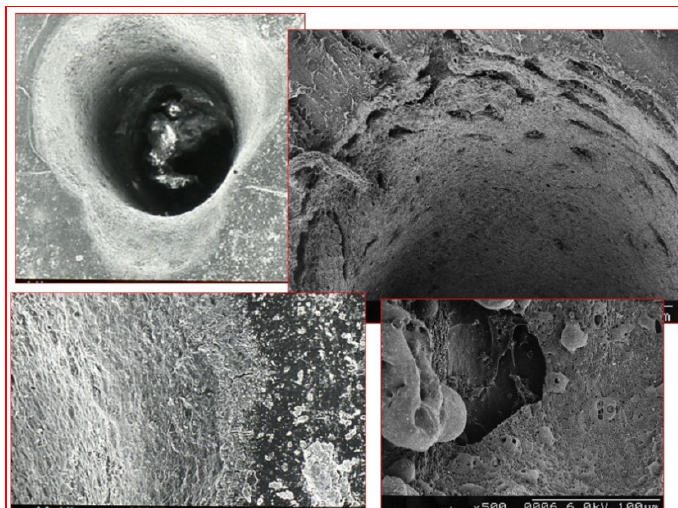
Figure 8. Scanning Electron Microscope (SEM) micrographs of laser-mediated enamel and dentine ablation. Top left and right: the resultant enamel surface is rugged, fragmented and capable of accepting a resin-based composite restoration once any unstable fragments have been removed. Bottom left and right: dentine is rendered smear layer-free, with an intact and stable cut surface.